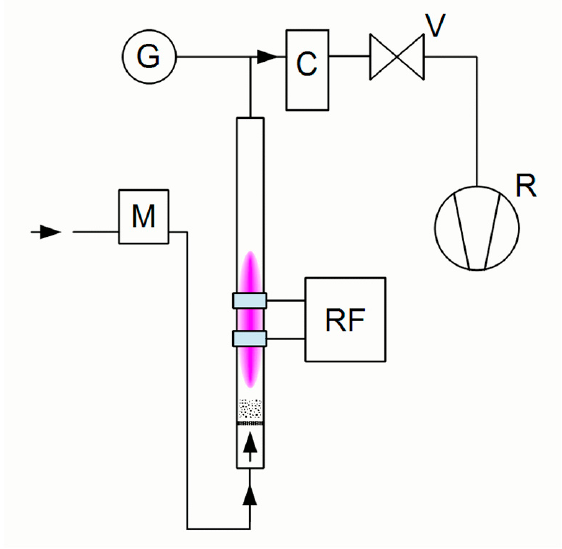
Figure 2. Diagram of RF reactor: G—vacuum gauge, C—cyclone, V—valve, M—mass flow controller, RF—generator with matching unit, R – rotary vane pump.